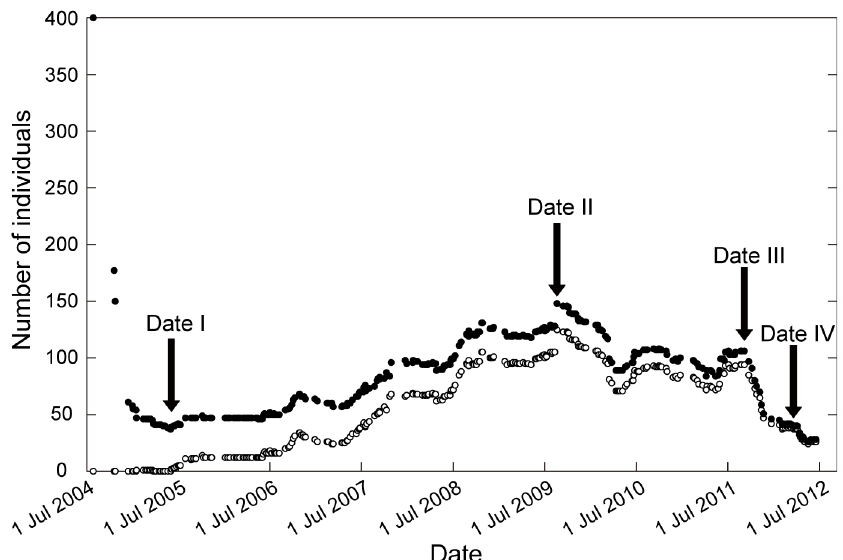
Fig 2. Population dynamics of S . gemmifer . The total population sizes of individuals (solid circles) and settled gemmae since February 2005 (open circles) are plotted from July 2004 to June 2012. Dates I – IV indicate the dates of culm measurements (Date I: 18 May 2005; Date II: 19 August 2009; Date III: 21 June 2011; and Date IV: 3 February 2012). Prior to Date I, the population size sharply decreased. The population size gradually increased during the period between Dates I – II and then decreased after Date II.